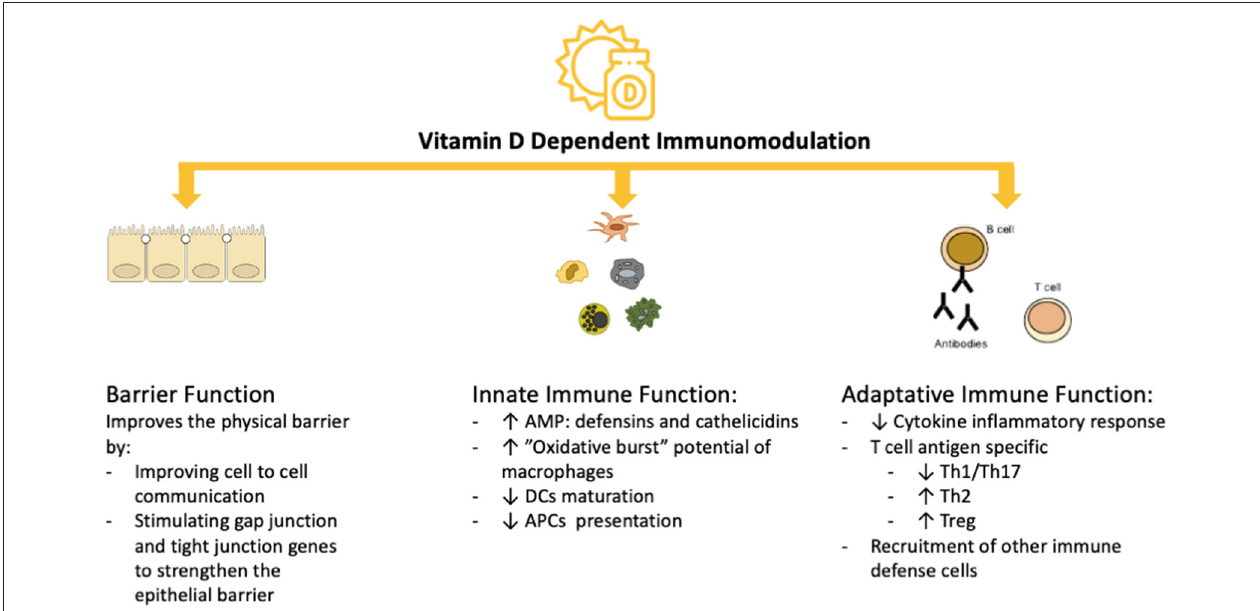
FIGURE 2 | Vitamin D-dependent Immunomodulation. AMP, antimicrobial peptides; APCs, antigen presenting cells; DC, dendritic cells; Th1, type 1T helper cells; Th17, type 17T helper cells; Treg, regulatory T cells.